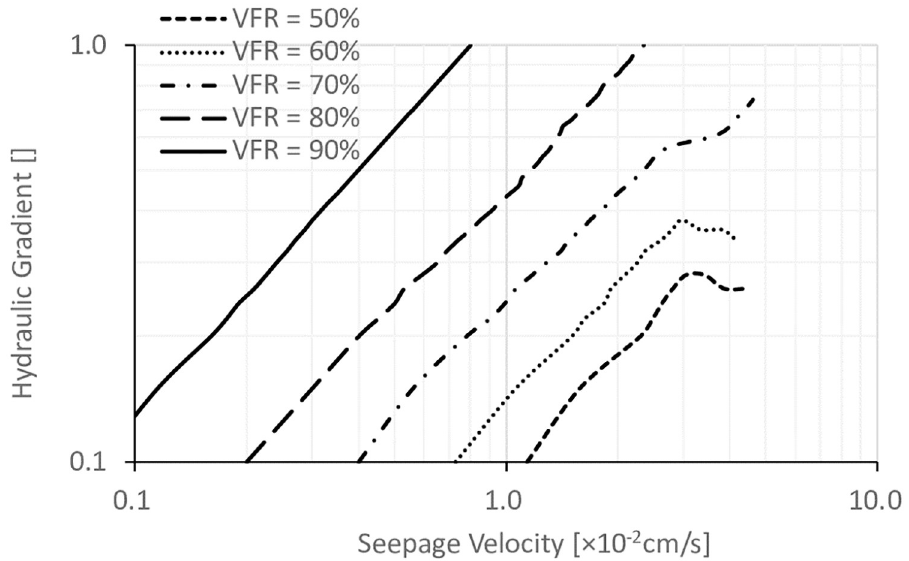
Fig 8. The relationship between the hydraulic gradient and the seepage velocity for specimens with different VFR values and D c = 85%.